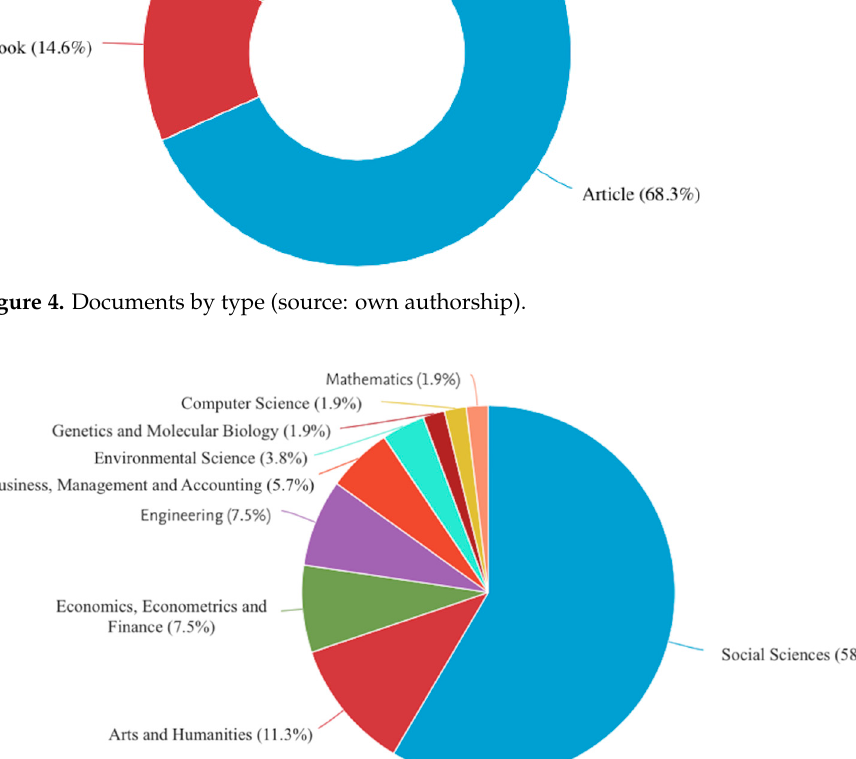
Figure 5. Documents by subject area (source: own authorship).